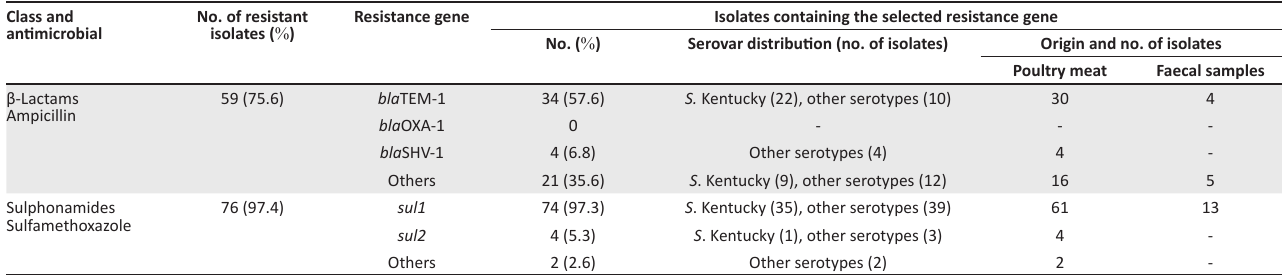
TABLE 4: Antimicrobial resistance genes and the resistance phenotype of S. enterica strains isolated from poultry meat and faecal samples ( n = 78). Class and